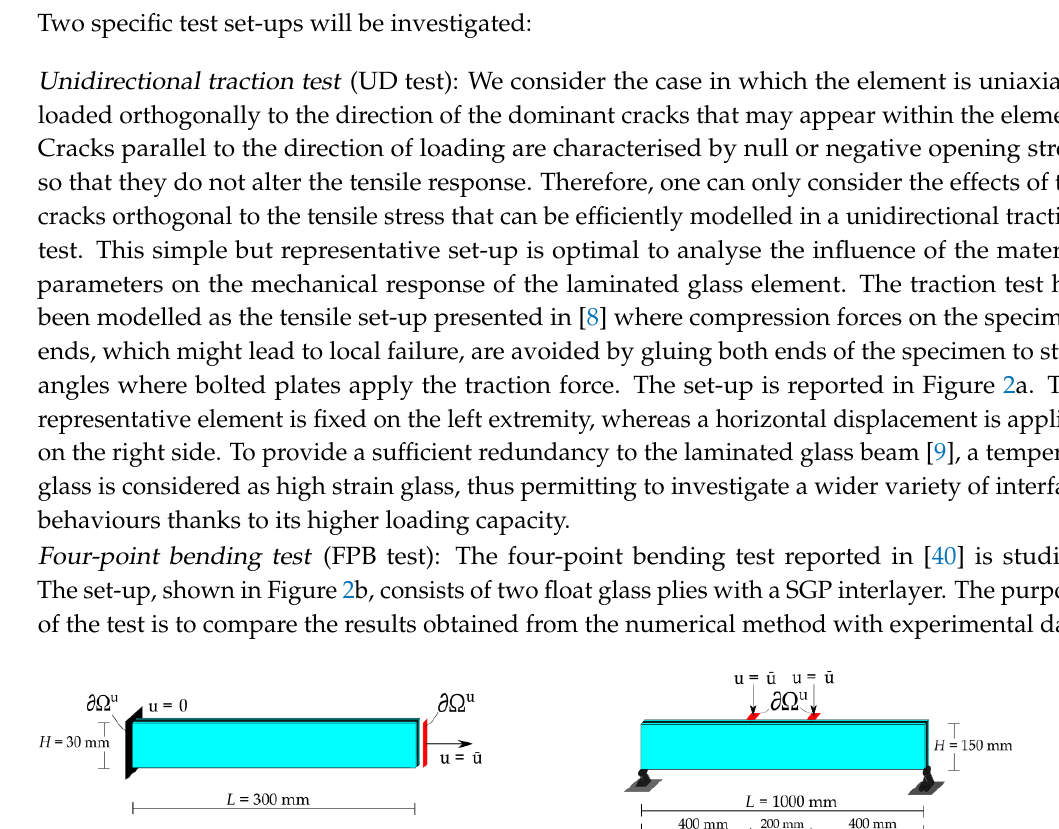
Figure 1. Physical and mechanical problem.